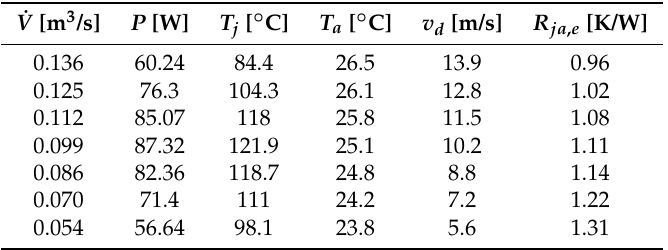
◦ C] T ◦ C] v a [ j [ d [m/s] R ja , e [K/W]